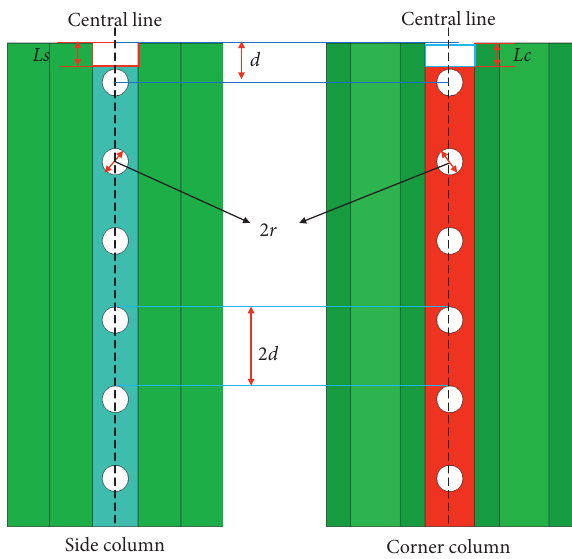
Figure 11: Variable distribution of windowed structures.